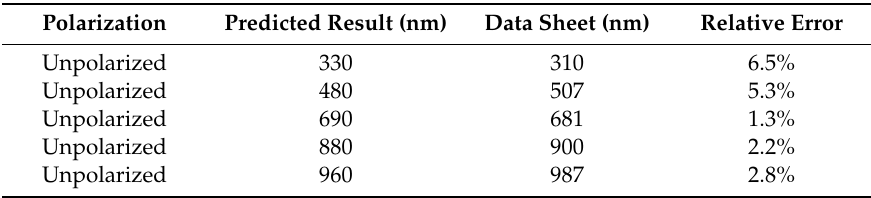
Table 2. Overview of silica size characterization